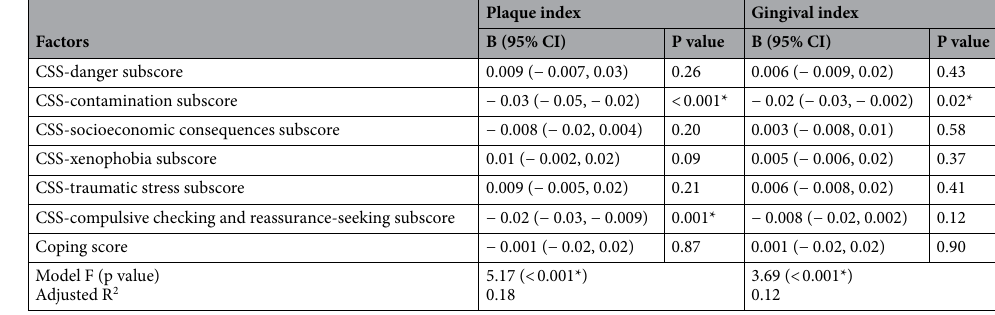
Table 2. Association of COVID-19 specific stresses and coping with plaque and gingival indices in adjusted multivariable regression. B Adjusted regression coefficient, CI confidence interval. Both models were adjusted for age in years, sex, and highest educational level, history of COVID-19 infection, having a close friend testing COVID-19 positive, knowing someone who died of COVID-19, xerostomia, smoking, toothbrushing, dental visits, and sugar consumption. *Statistically significant at p value < 0.05. For the CSS- Contamination subscore, the E-value of the plaque index model = 1.25 and of the gingival index model = 1.21. For the CSS-compulsive checking and reassurance-seeking subscore, the E-value of the plaque index model = 1.20.